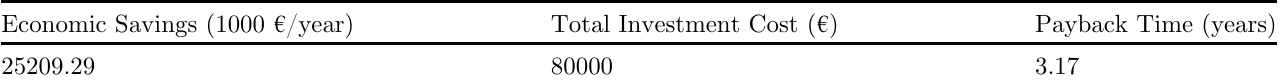
Table 7. Determination of payback